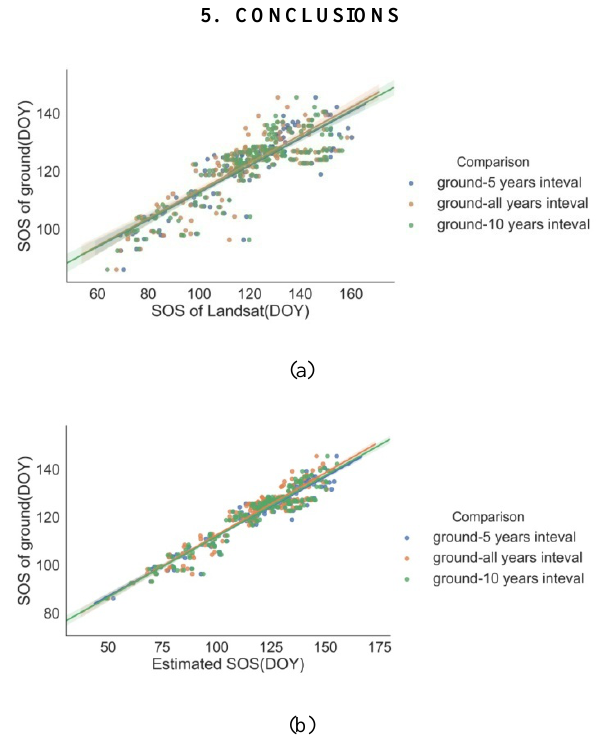
Figure 6. Correlation of SOS among LSP SOS, ground SOS and estimated LSP SOS ((a) correlation between LSP SOS and ground SOS, (b) adjusted correlation of SOS between estimated LSP SPS and ground